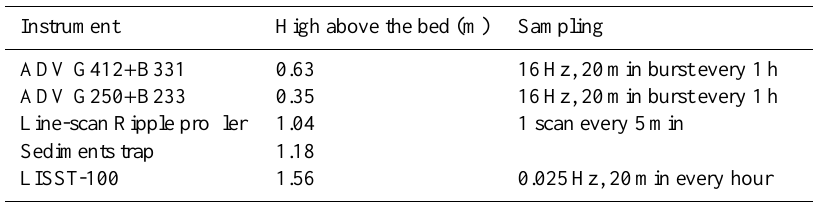
Table 1. Instrumentation in mini-STABLE rig deployed in the Welsh Channel.